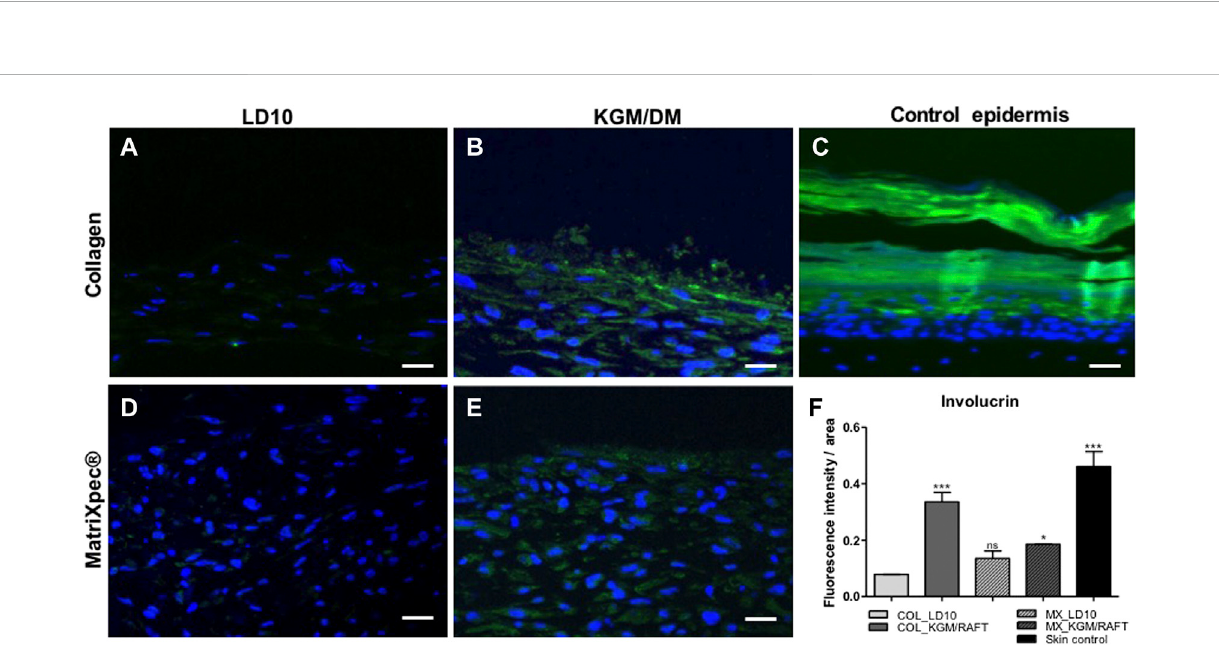
comparison to the ones cultivated with LD10 (control). This difference was less marked between MSC cultivated onto MatriXpec KGM/DM or LD10.